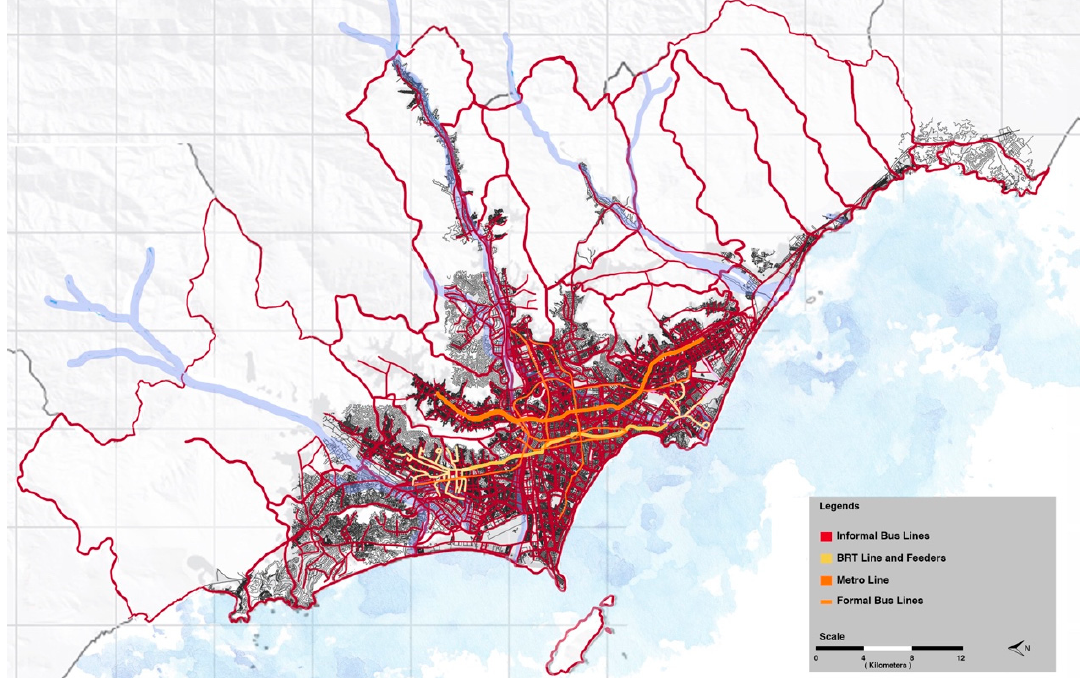
Figure 5. Metropolitan area of Lima with informal transit network, BRT, Line 1 of Metro, and Complementary Corridors (formal bus lines). Source: References [13,32,35,39]. Map by authors.